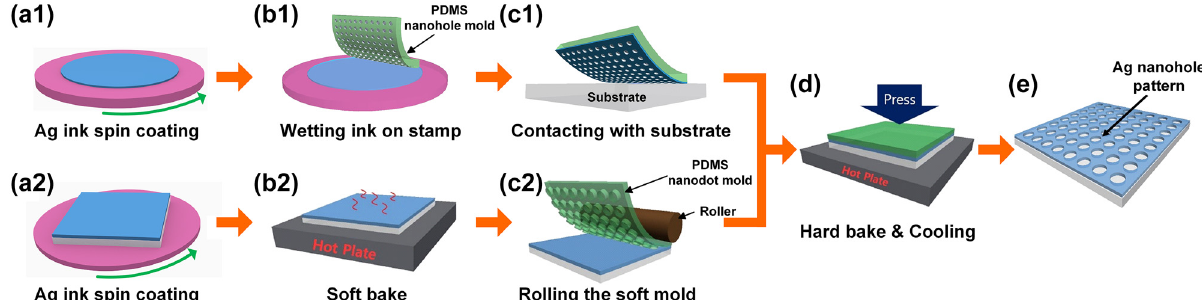
Figure1: Schemesoftheproceduresofsoft-contactpatterningofAgnanostructuresintwomainroutes.TransferprintingofAgnanostructures proceedsintheorderof(a1)ionicAginkcoating,(b1)wettingthePDMSmold,and(c1)contactingwiththetargetsubstrateandAg-inkedPDMS mold. Soft NIL process of Ag nanostructures consists of (a2) ionic Ag ink coating on the target substrate, (b2) soft baking of the ionic Ag ink layer, and (c2) uniform contacting of the PDMS mold by using a roller. Both processes follow (d) hard baking with gentle pressure and cooling to complete (e) fi nal Ag